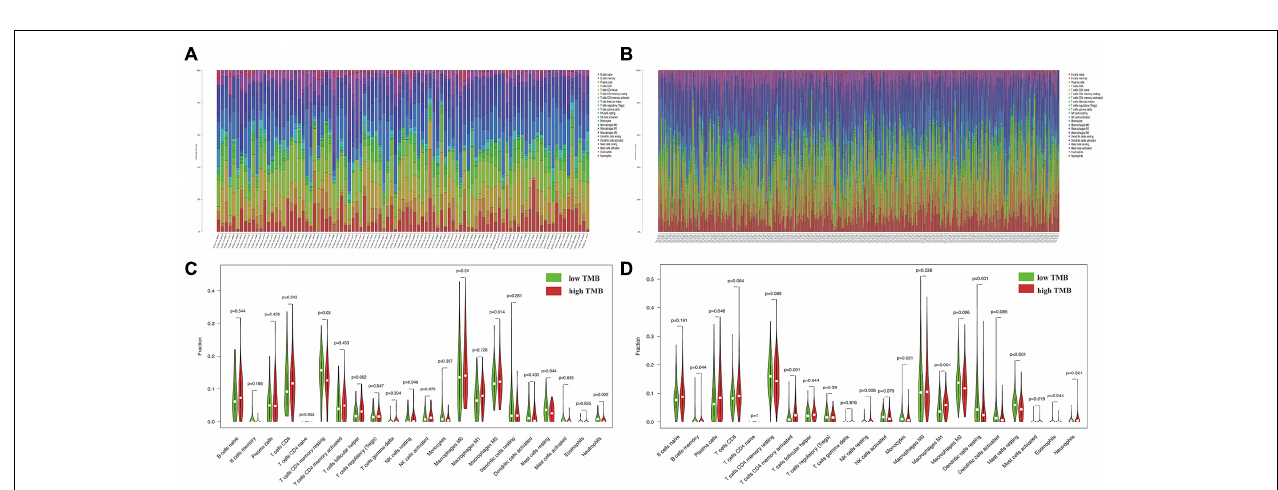
FIGURE 9 | Visualization of the mutation profile signature in each cluster. (A,B) Waterfall plot of mutation profiles in cluster 1 and cluster 2 in LUAD samples. The comments below mean the mutation types. The bar chart on the right shows the distribution of mutant types in the top 30 genes. (C,D) The oncogenic pathways of mutant genes in cluster 1 and cluster 2. TMB, tumor mutation burden; LUAD, lung adenocarcinoma.